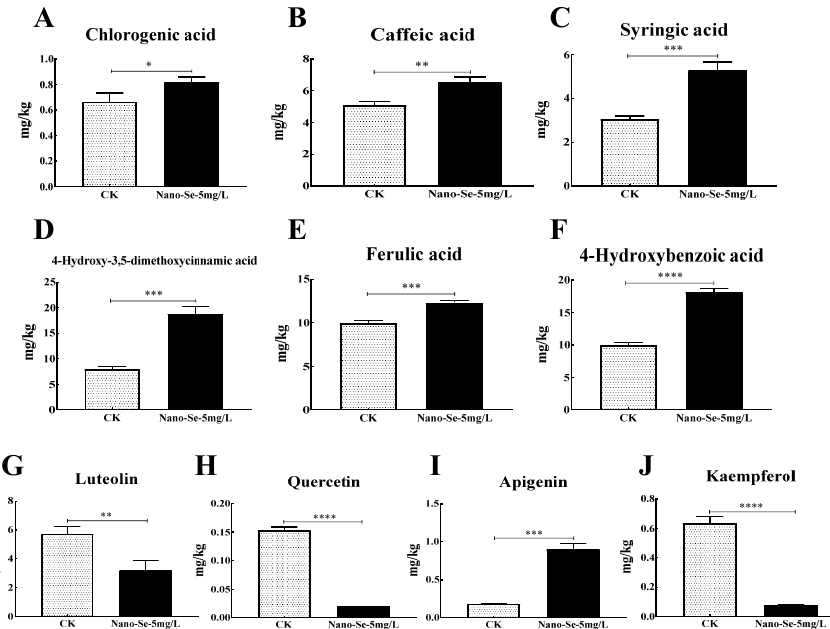
Figure 2. Effects of nano-Se on chlorogenic acid ( A ), caffeic acid ( B ), syringic acid ( C ), 4-hydroxy-3,5-dimethoxycinnamic acid ( D ), ferulic acid ( E ), 4-hydroxybenzoic acid ( F ), luteolin ( G ), quercetin ( H ), apigenin ( I ), and kaempferol ( J ) levels in S. grosvenorii . Data are presented as mean ± SEM (* p < 0.05, ** p < 0.01, *** p < 0.001, **** p < 0.0001. n = 3).